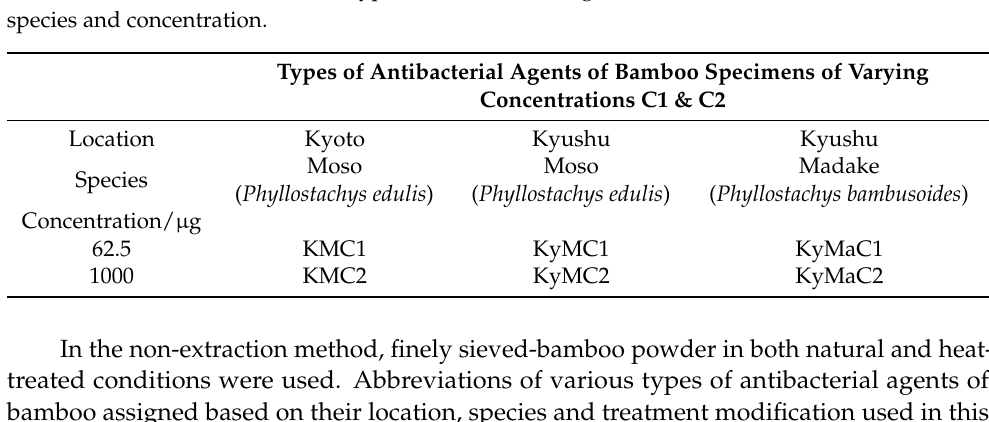
Table 2. Abbreviations of various types of antibacterial agents of bamboo assigned based on their location, species and treatment modification.